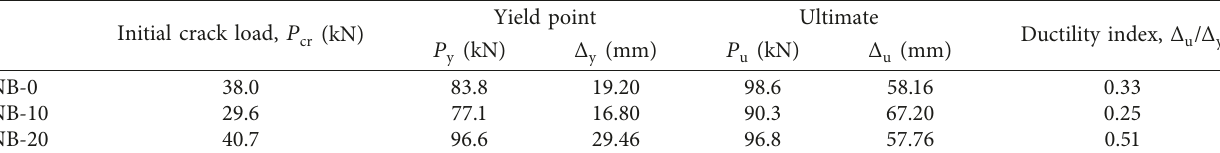
Figure 19: Load-displacement and load-steel strain curve of NB Table 18: Initial crack load and ultimate load and ductility of NB specimens.